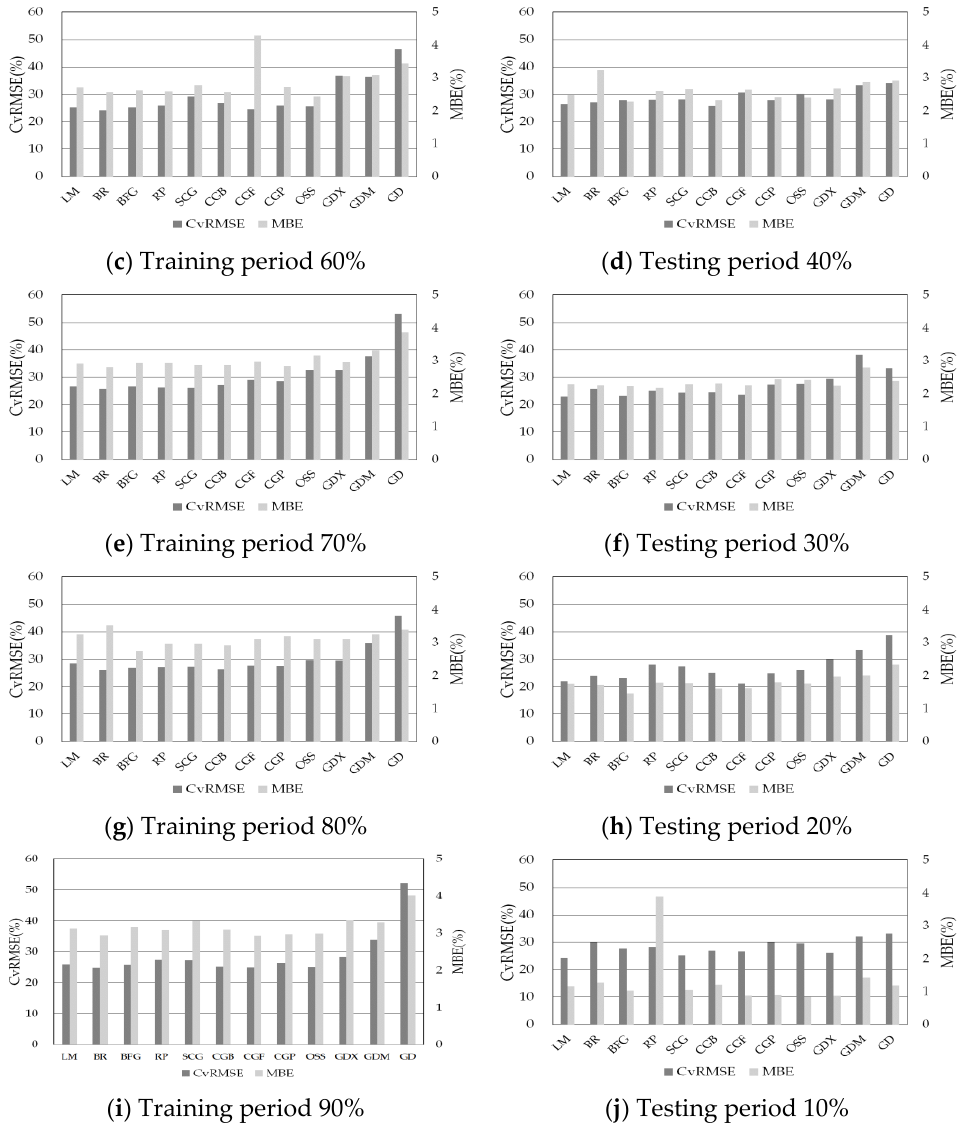
Figure 4. CvRMSE and MBE prediction results with train period 50 – 90%/test period 50 – 10% in data.